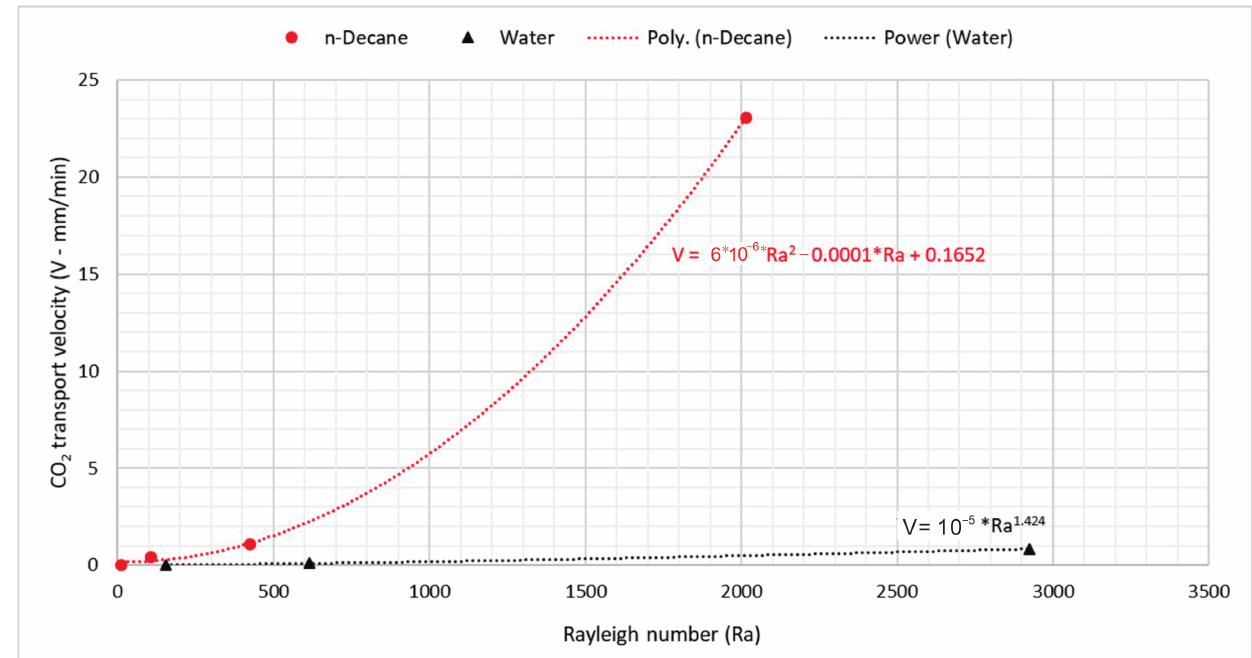
Figure 12. CO 2 transport speed (mm/min) as a function of Rayleigh number (Ra) for n -decane (this study) and for water [24] in 3-dim column experiments.